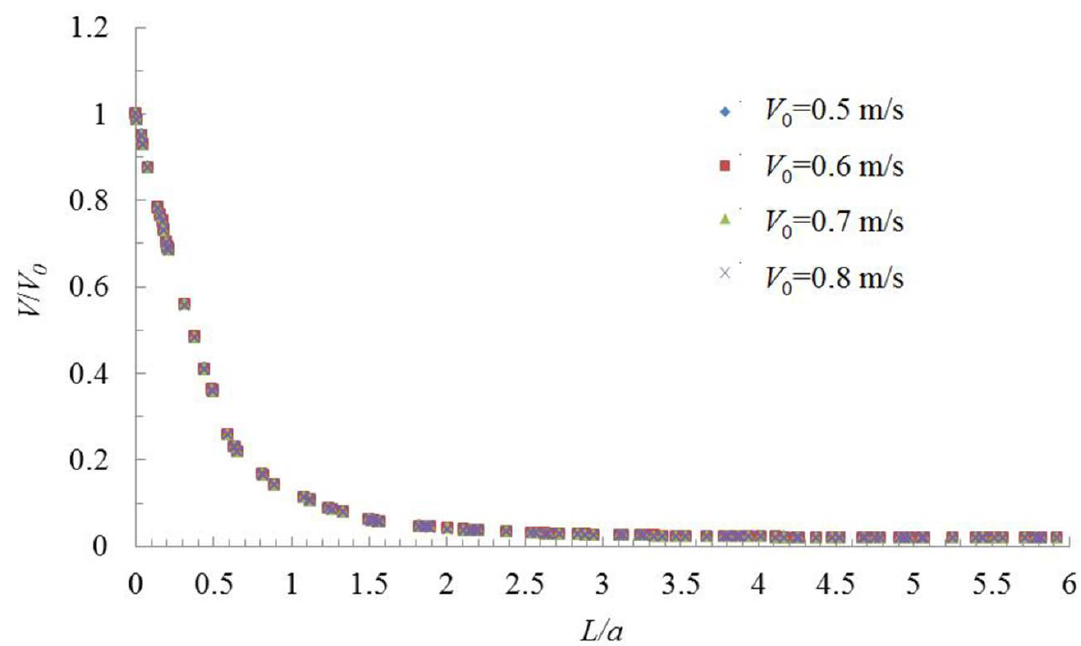
Figure 4. Dimensionless change in hood axis velocity ( V / V 0 ) with dimensionless distance from hood face ( L / a ) for various hood face velocities ( V 0 ).